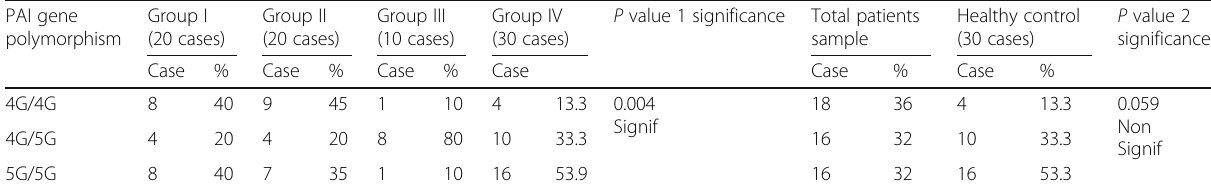
Table 6 Frequency distribution of PAI-1 gene polymorphism PAI gene Group I polymorphism (20 cases)